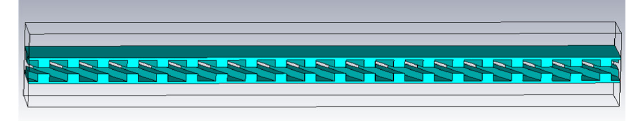
FIG. 2. Tilted Bragg cavity grating, where the dual drive laser comes from top and bottom and is polarized in the electron beam direction (left to